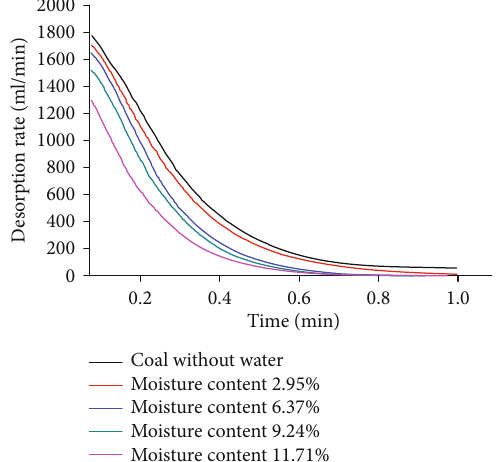
Figure 5: Comparison diagram of the change laws of the gas desorption speeds with time under di ff erent water content conditions.